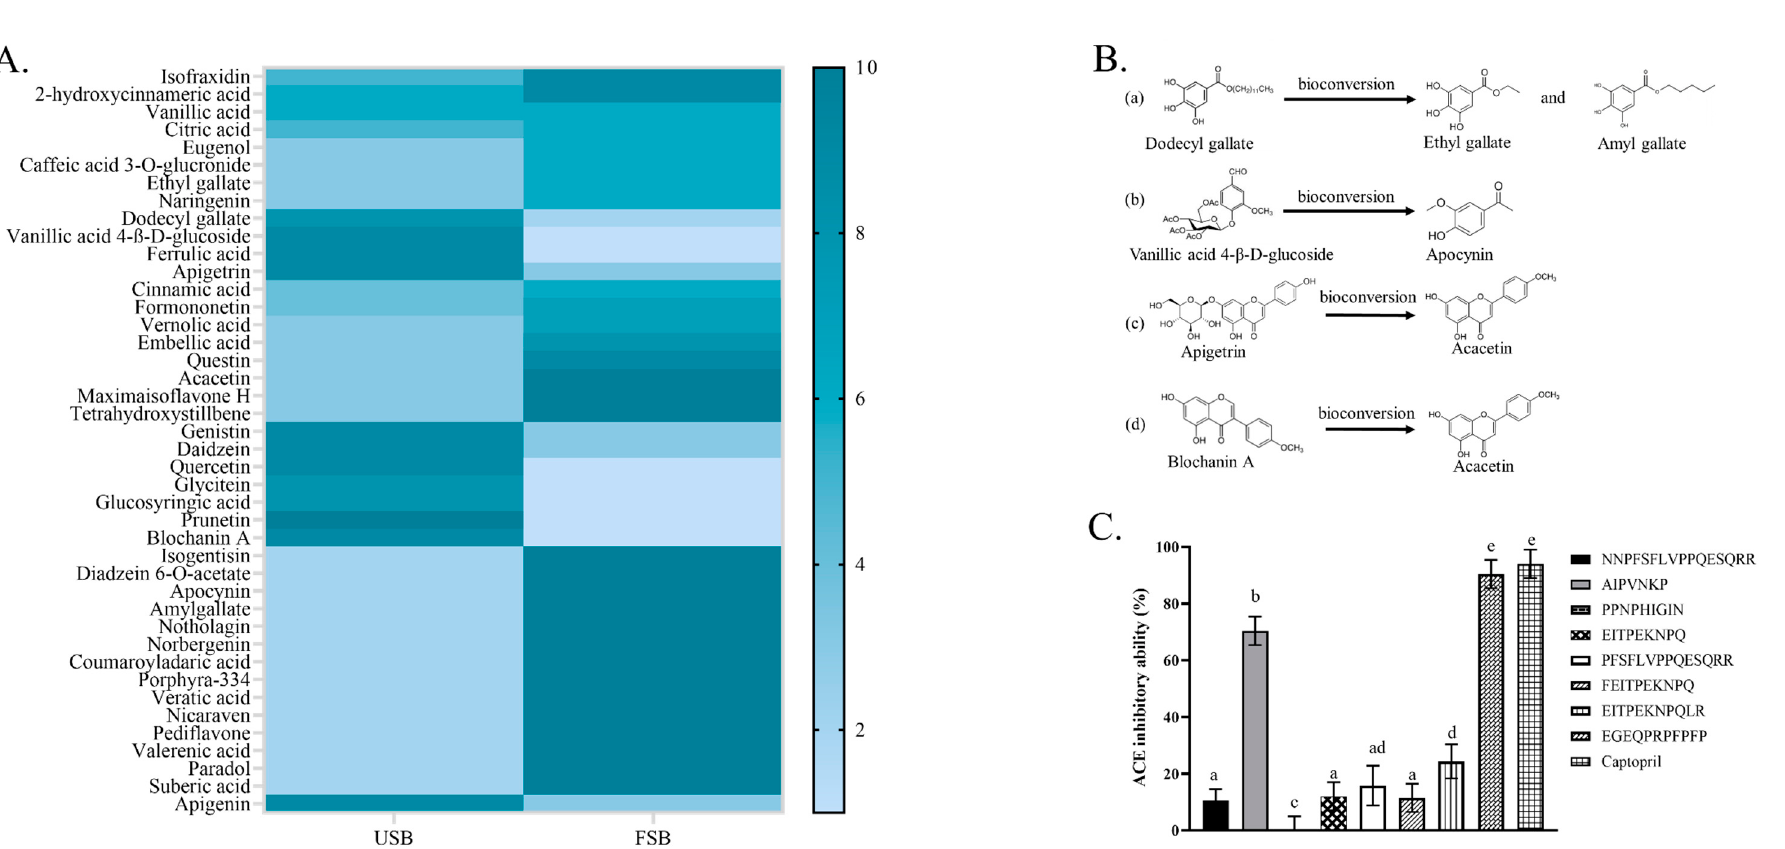
Figure 2. Relative levels of phenolic compounds in USB and FSB and ACE inhibitory abilities of newly identified peptides. ( A ) Heat map shows the different levels of phenolic compounds present in the samples. The color range from green to white represents higher to lower levels of phenolic compounds and the values of 2 to 10 indicate the relative concentrations of the compounds, ( B ) shows bioconversion of some phenolic compounds into new compounds during the fermentation process ( C ) newly identified peptides and their ACE inhibitory abilities. Bars with different alphabets indicate significant differences ( p < 0.05).